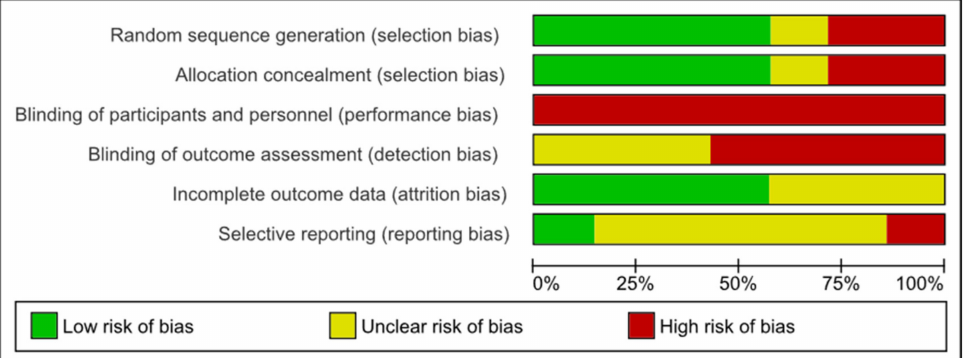
Figure 3. Risk of bias: systematic review authors’ judgments about each risk of bias item presented as percentages across all included trials using the Cochrane risk of bias tool ( n =